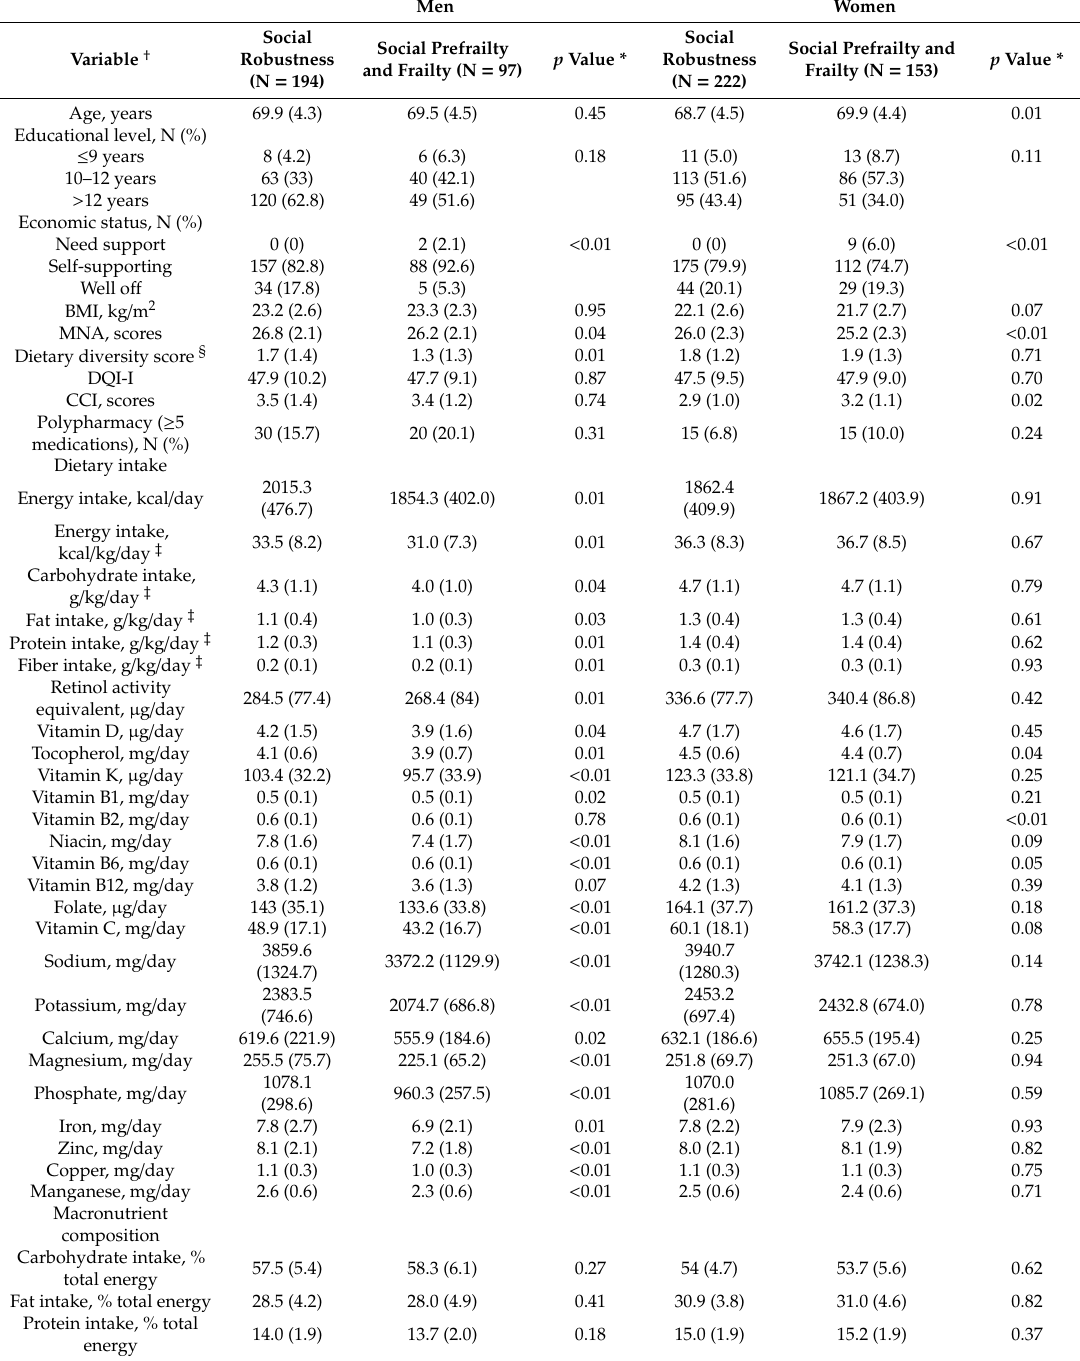
Table 1. Participants’ baseline characteristics by sex and social frailty